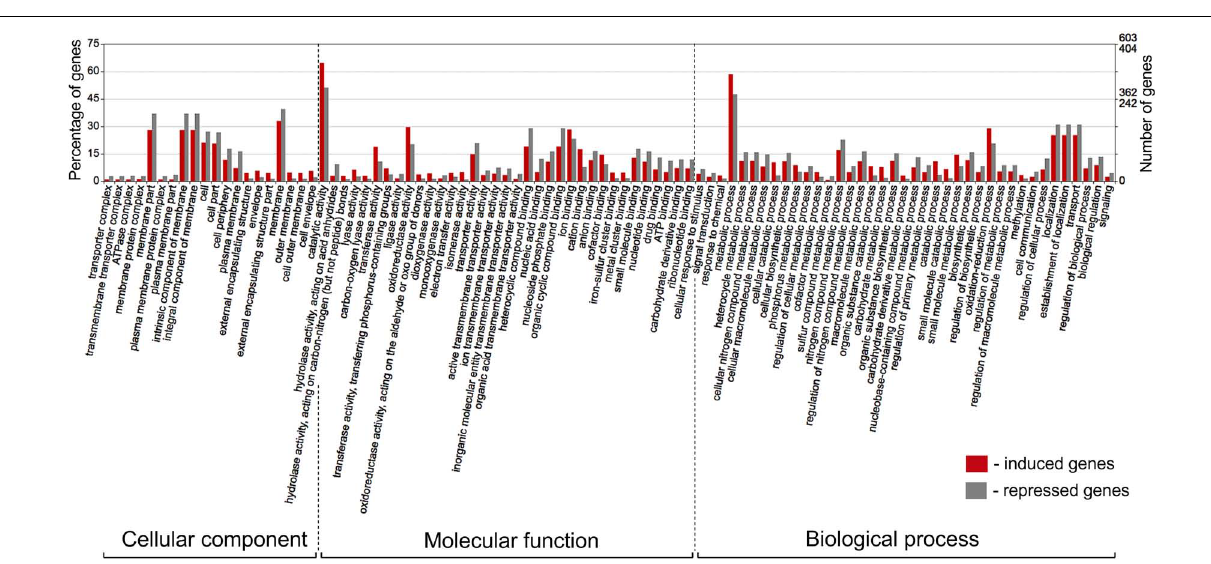
FIGURE 6 | Gene Ontology (GO) classification of Pseudomonas genes that were induced (red bars) or repressed (gray bars) in response to root exudates of B. distachyon Bd21. The terms were derived from 93 different functional groups (GO subcategories level 4). The GO terms were assigned with Blast2GO (Conesa and Gotz, 2008) and visualized in WEGO 2.0 (Ye et al., 2018). On a WEGO histogram, the percentage of 100 is defined as the total number of genes assigned a GO term. However, the subcategories do not add up to 100% because many genes fall into more than one functional class and are therefore annotated by multiple GO